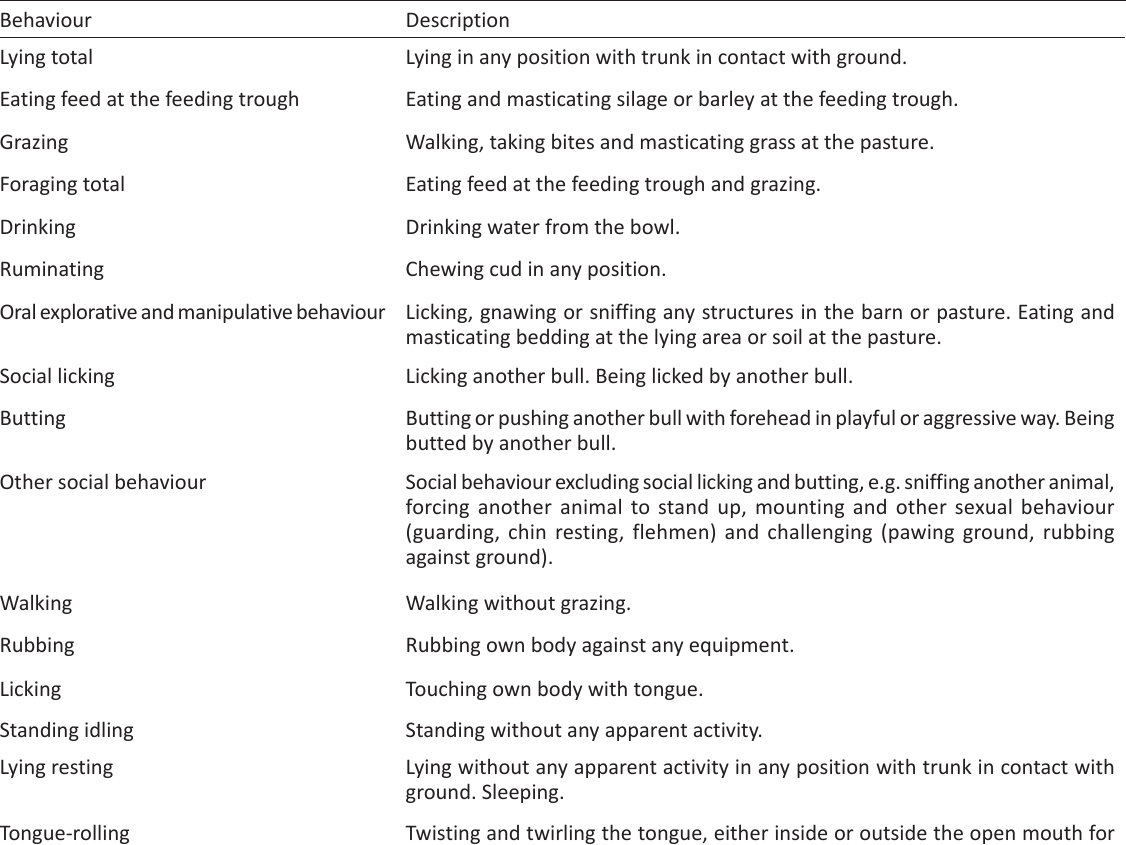
Table 1. Description of postures and activities recorded during instantaneous sampling observations Behaviour